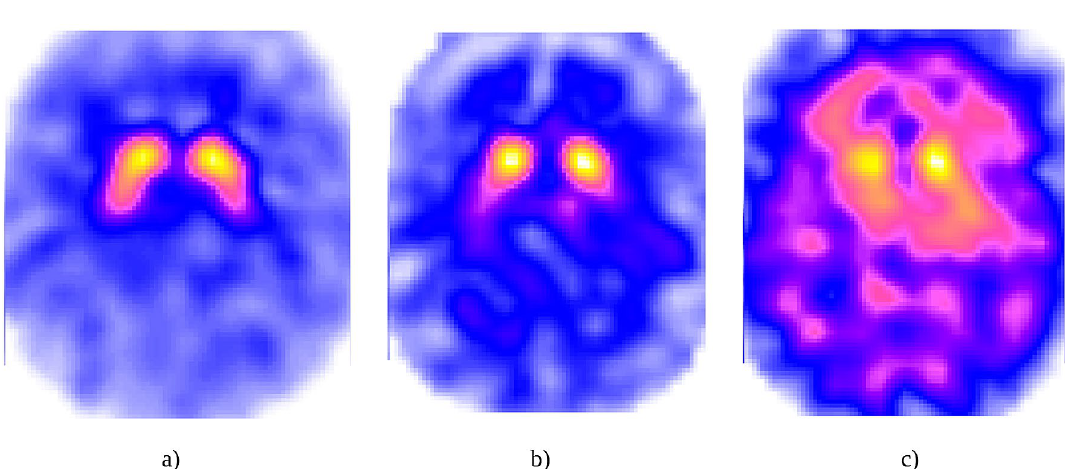
Figure 4. Example of a patient of each class: ( a ) without alteration (class 0), ( b ) with a slight alteration (class 1), and ( c ) with a severe alteration (class